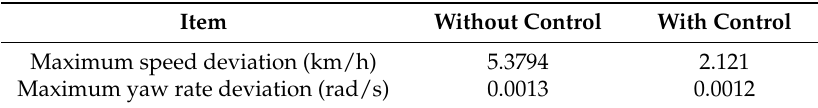
Table 7. Statistical control effect under F2 condition.